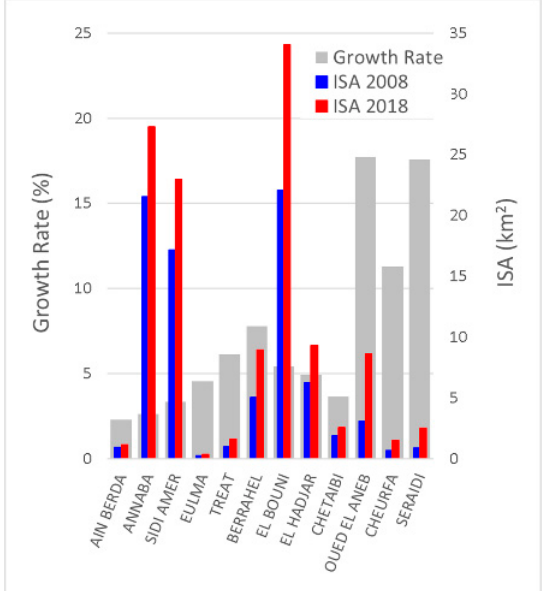
Figure 17. Impervious surface area (ISA) (km 2 ) and its growth rate (1/10 of percent) for the communes in the Annaba wilaya between 2008 and 2018.